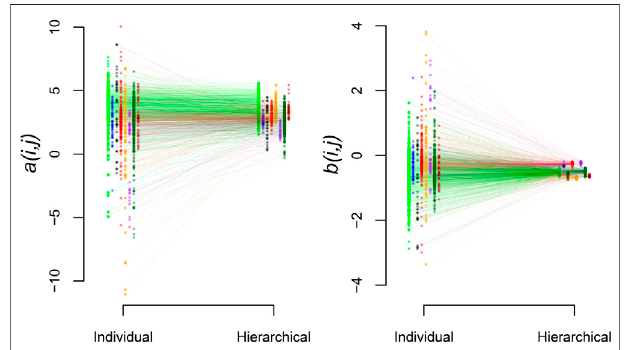
FIGURE 5 | Shrinkage of station estimates toward the biome-level values. Results are shown for a (left panel) and b (right panel). Within panels, mean station-level parameter estimates are shown for the individual and hierarchical analysis. Biome groups have distinct colors and are horizontally offset relative to one another for visualization. Lines connect individual stations estimated with both approaches.